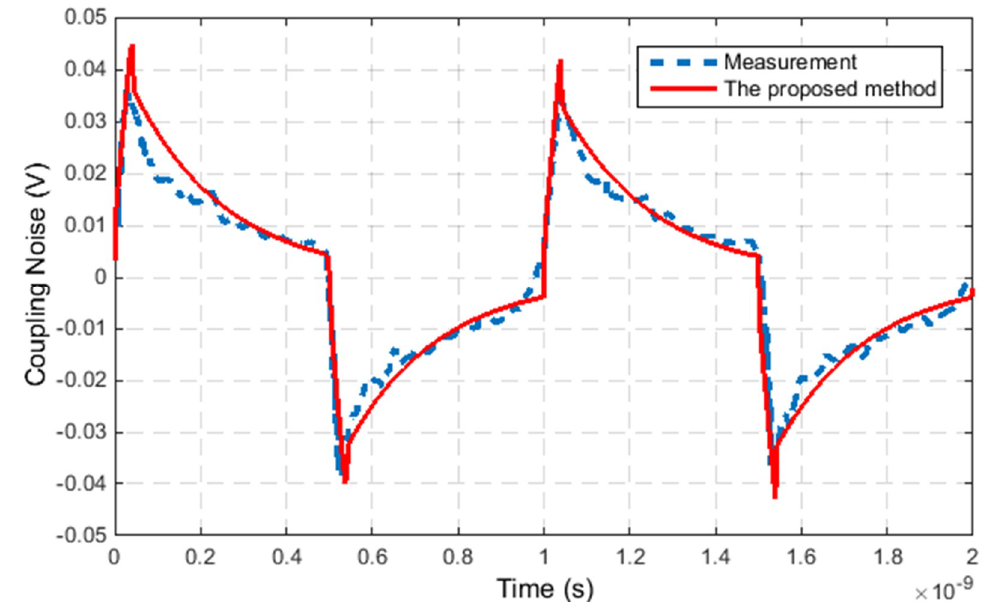
Figure 10. The proposed method and measured coupling of the TSV–TSV test vehicle (the input clock frequency at port 1 is 1 GHz).